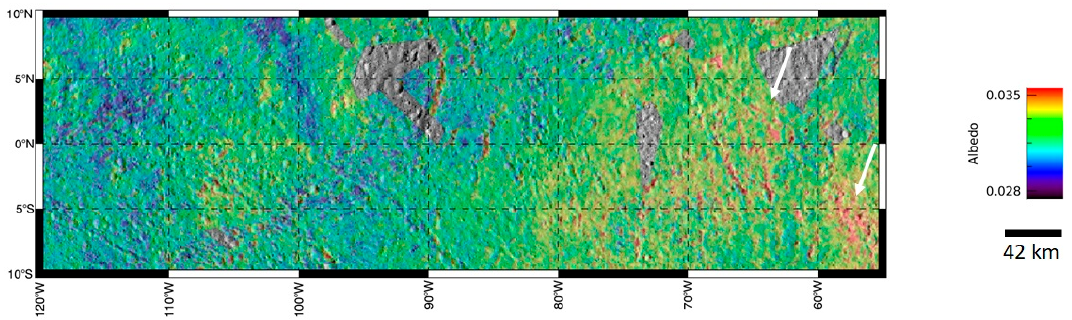
Figure 8. Albedo increase (highlighted by white arrows) observed in correspondence to the eastern feature of the Samhain Catenae (cylindrical projection).